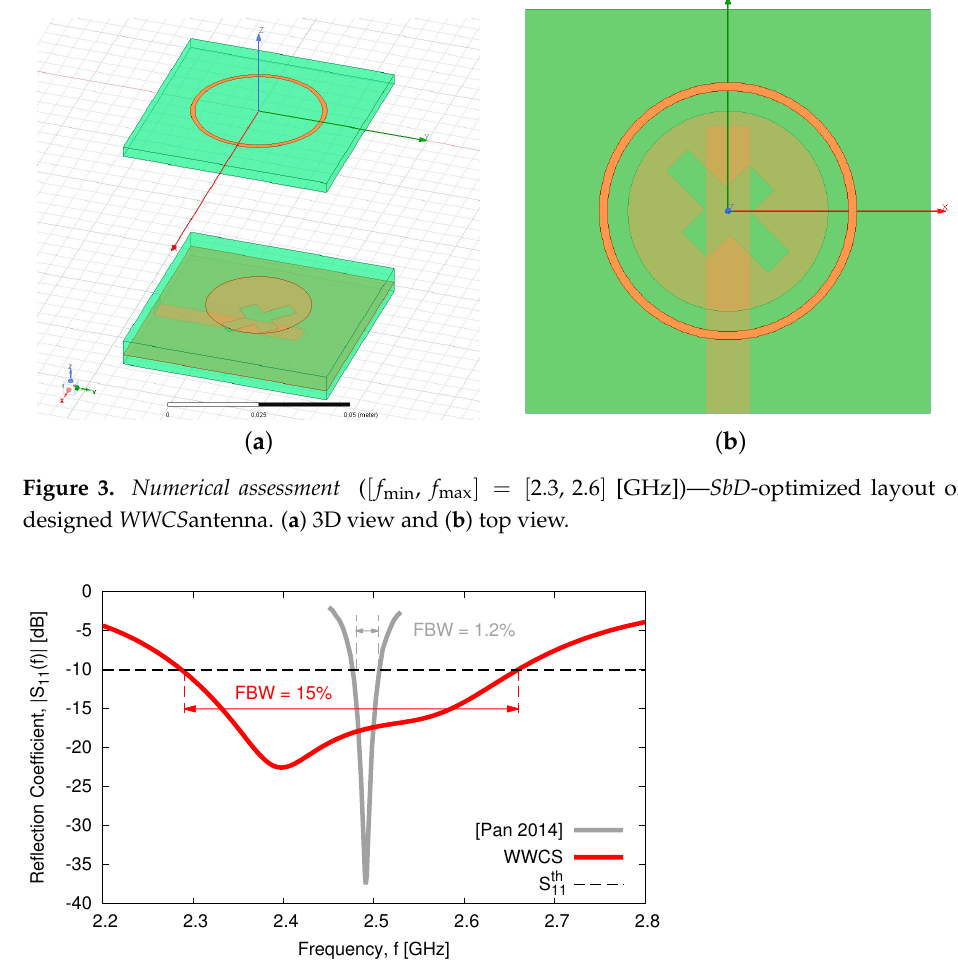
(cid:12) (cid:12) ( dB ) (cid:12) (cid:12) ( f ) (cid:12) S (cid:12) , and comparison with the literature results in 11